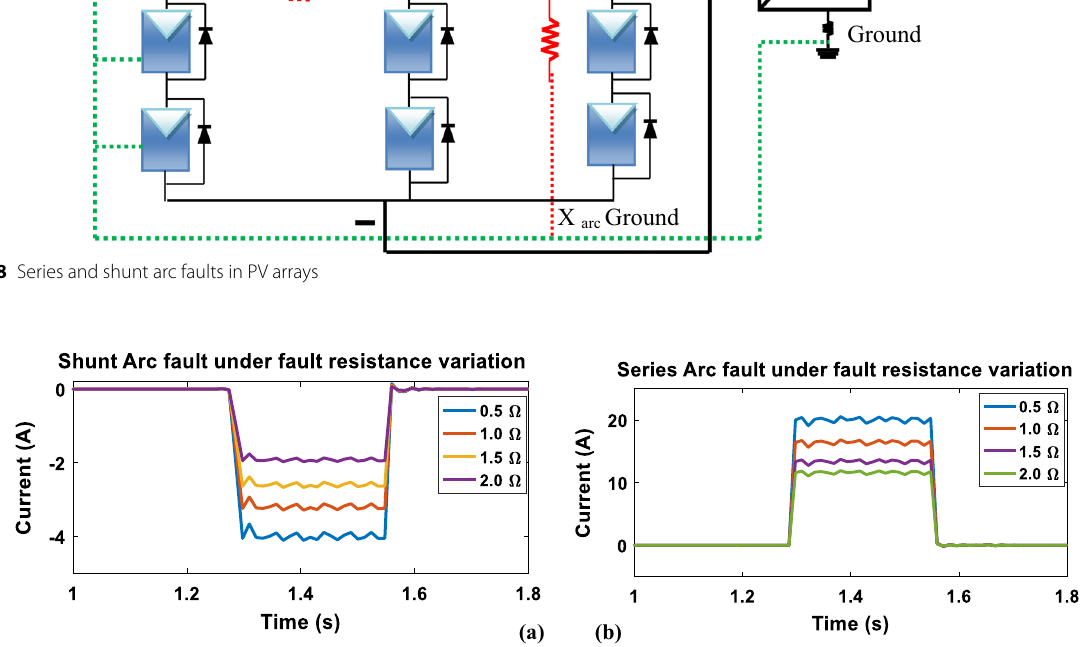
Fig. 9 Arc faults under fault resistance variation a series arc fault, b shunt arc fault